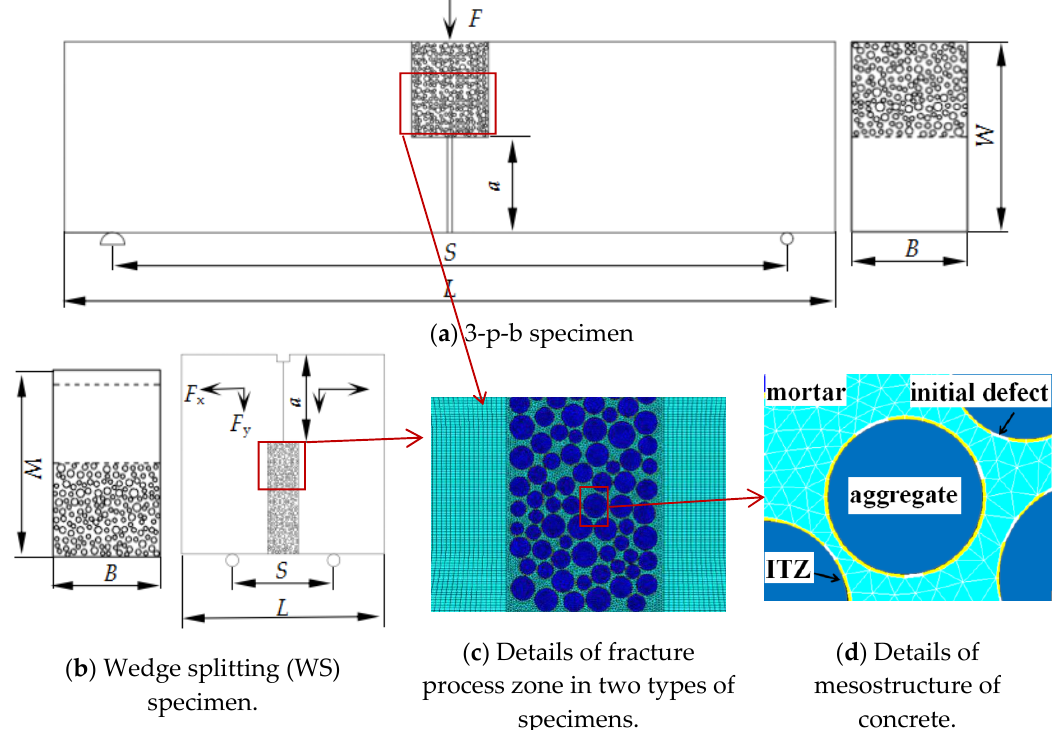
Figure 1. Schematic diagram of concrete meso-model.